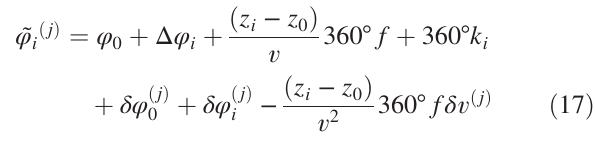
LASER-ASSISTED CHARGE EXCHANGE AS AN ATOMIC … PHYS. REV. ACCEL. BEAMS 24, 032801